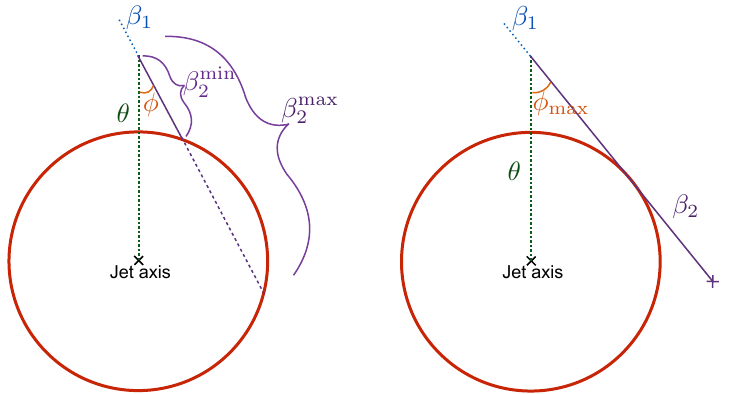
Figure 5 . Geometry of the central subjet when the recoil (cid:18) is larger than the radius r . In the left panel the minimum and maximum values of (cid:12) 2 are shown such that this parton is inside the central subjet. The right panel depicts the maximum value of (cid:30)